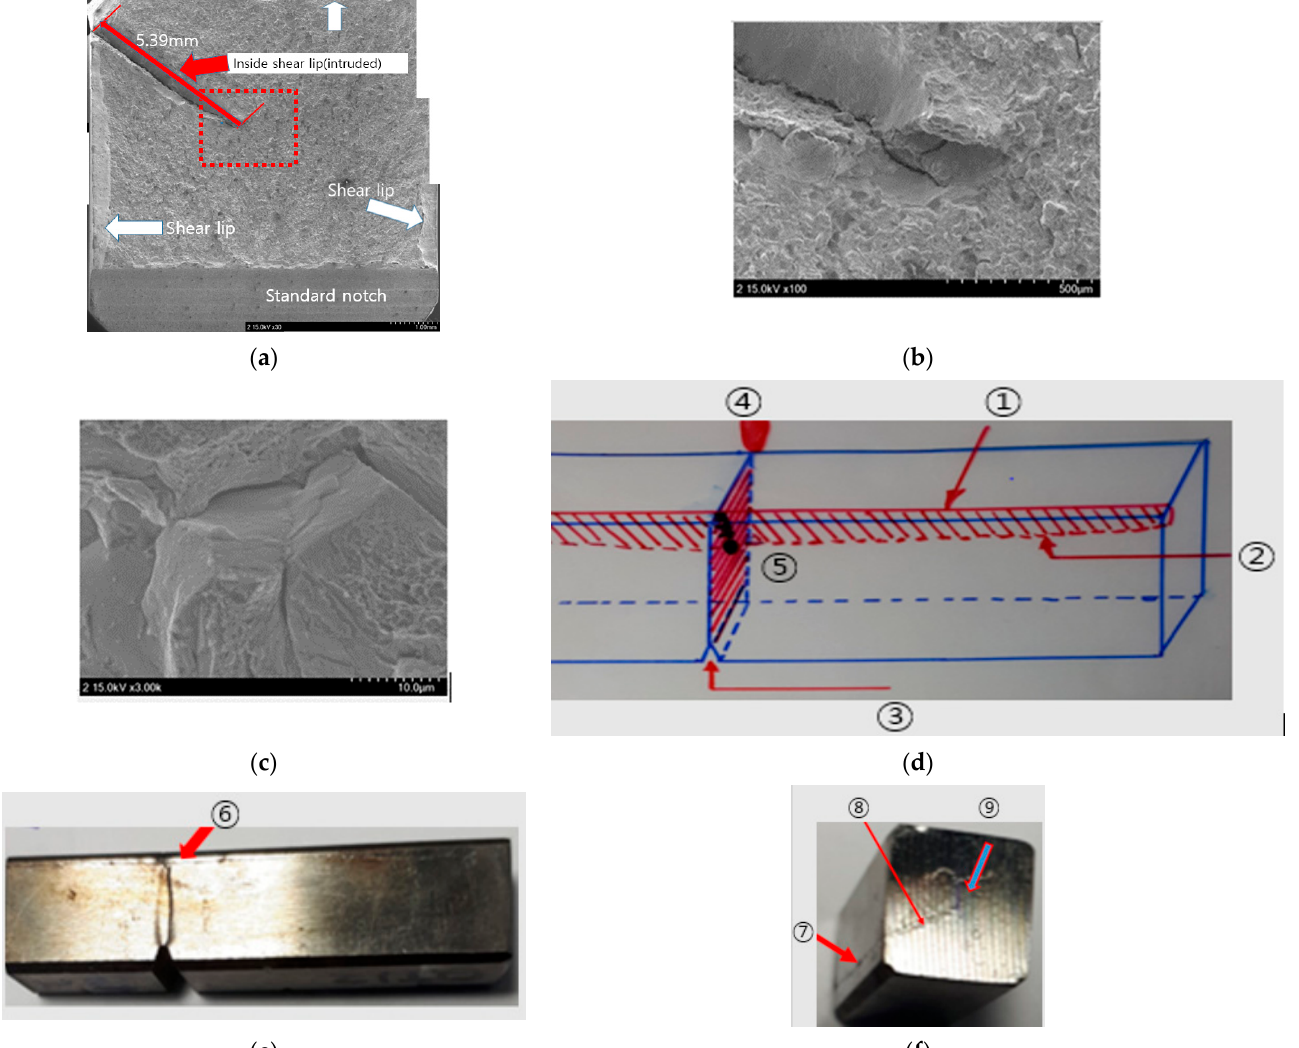
Figure 17. Charpy impact fractured surfaces of the QT specimen. ( a ) 30×, ( b ) 100× and ( c ) 3000×. ( d ). A schematic of the impacted specimen of ( e ), ① indicates a semi ‐ elliptical brittle surface crack formed up to 55 mm in length and 5.39 mm in depth during the impact test. The part indicated by the diagonal line ② is the internal shape of the semi ‐ elliptical brittle surface crack, ③ is a notch and is a fracture surface made by the impact test, ④ indicates a knife edge of the impact tester, ⑤ shows the same fracture surface as ( a ), indicating that a brittle crack with a depth of approximately 5.39 mm propagates instantaneously in the overall length (55 mm) direction of the specimen. ( e , f ) Arrows ( ⑥⑦ ) indicate a long outside brittle surface crack formed by the impact test (corresponds to ( d ) ( ① ) ⑧ indicates the depth of the crack of approximately 5 mm (corresponds to ( d ) ( ② ). Arrow ⑨ in photo ( f ) indicate the crack tip.